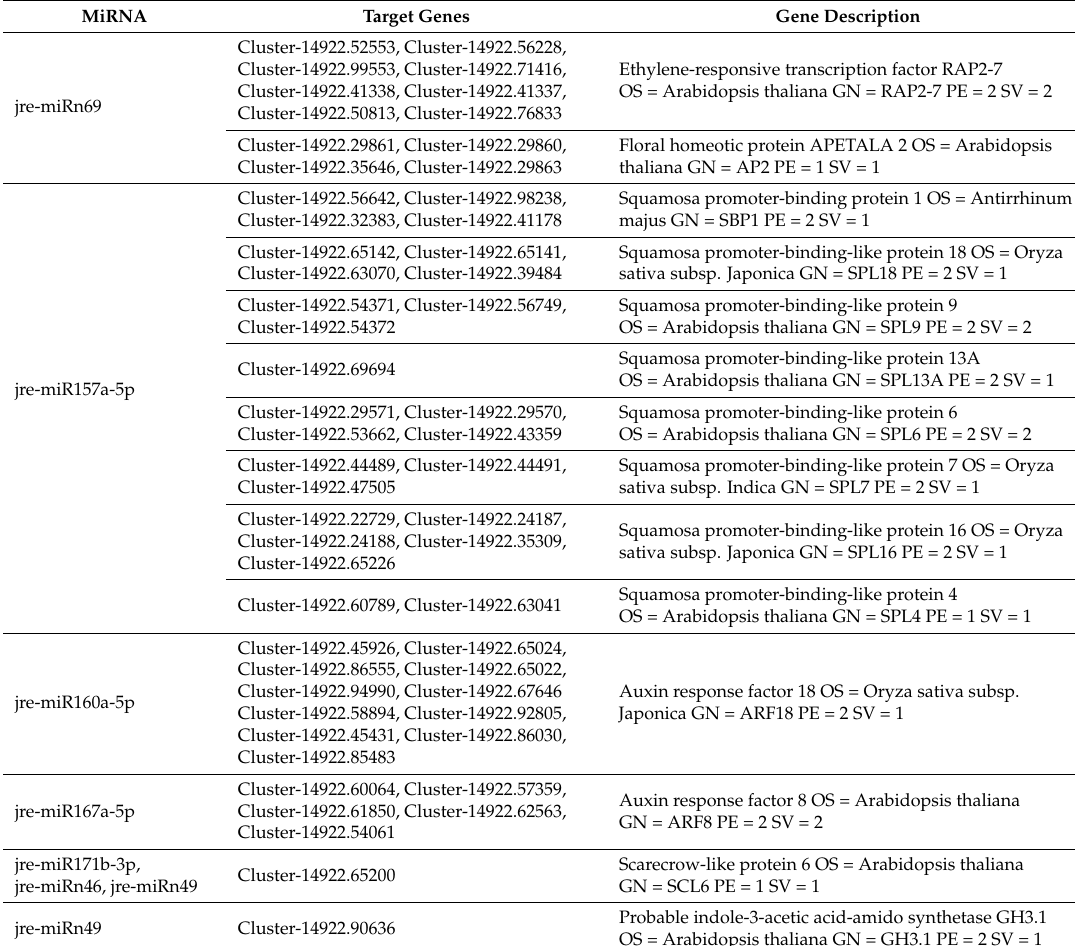
Table 2. Flower induction-related miRNAs and target gene